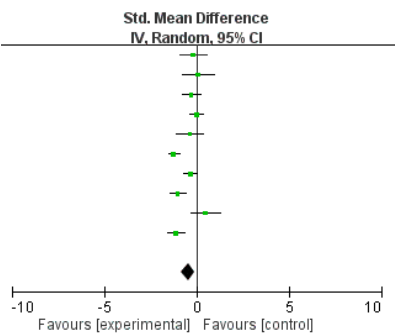
Table 4. Effect of qigong on anxiety symptoms in comparison to non-mindful exercise.